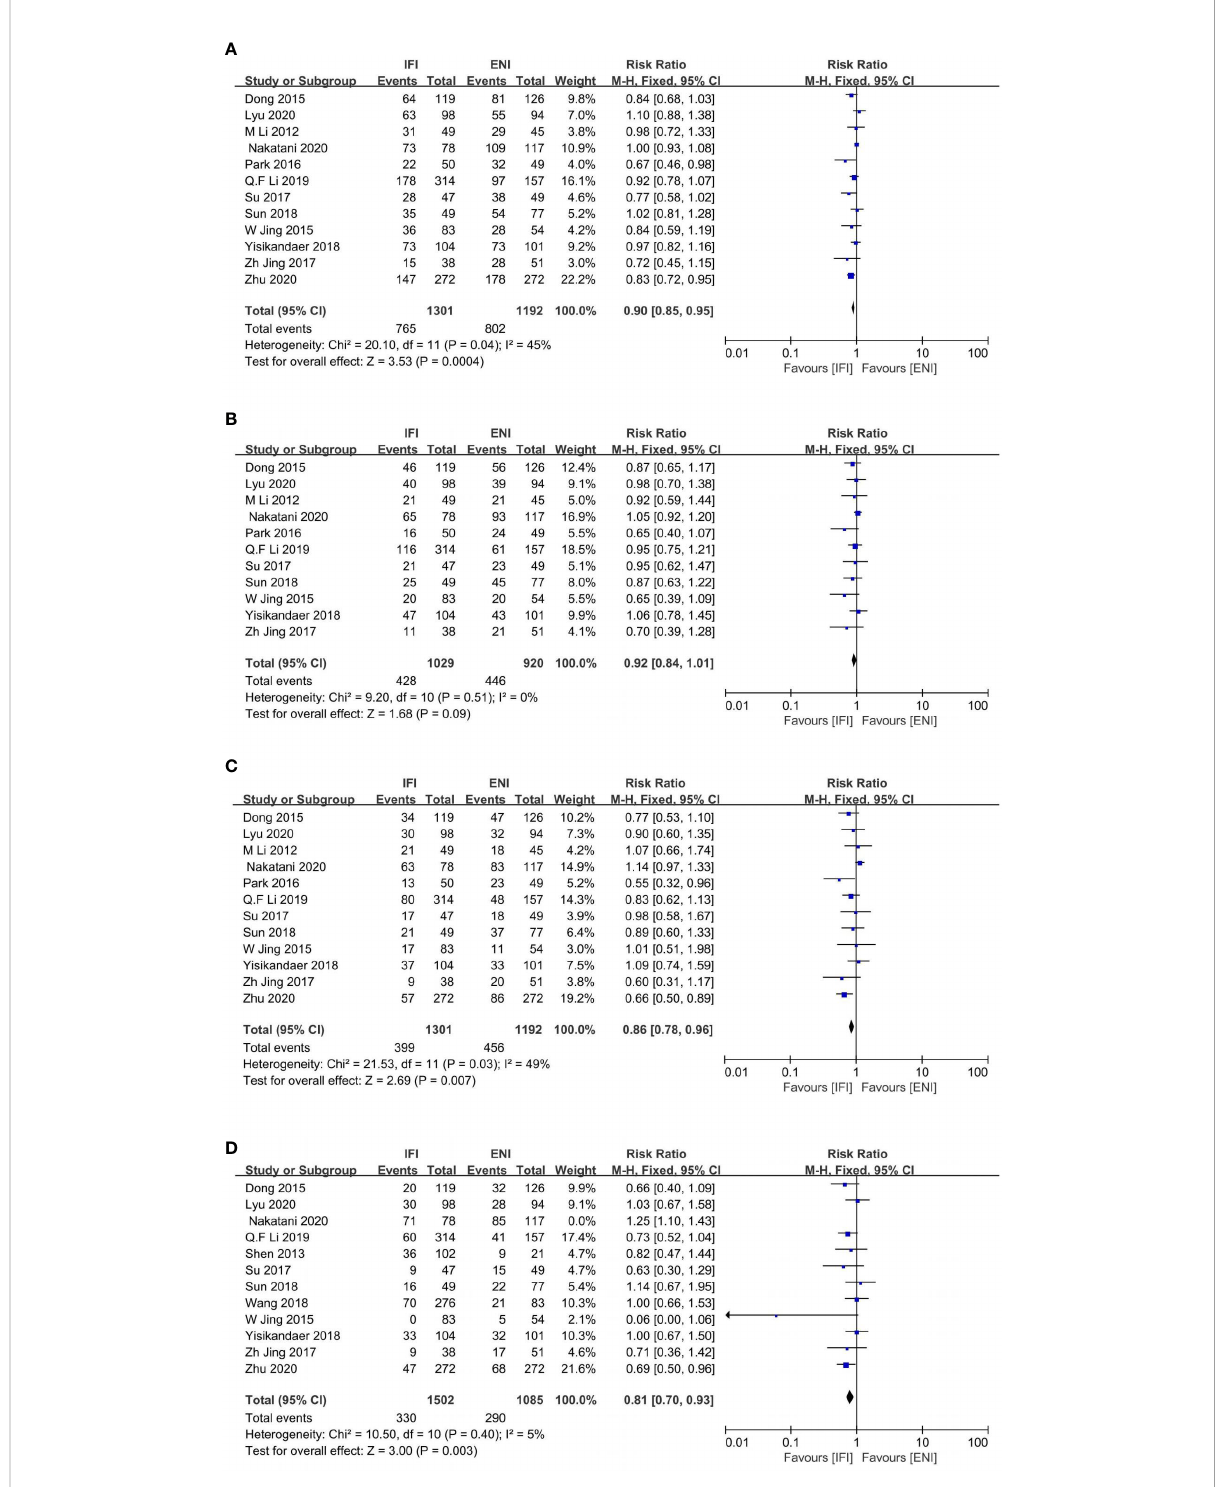
FIGURE 4 Forest plot of 1- (A) , 2- (B) , 3- (C) and 5-years (D) progression free survival rate. IFI, involved fi eld irradiation; ENI, elective nodal irradiation; M-H, Mantel-Haenszel; CI, con fi dence